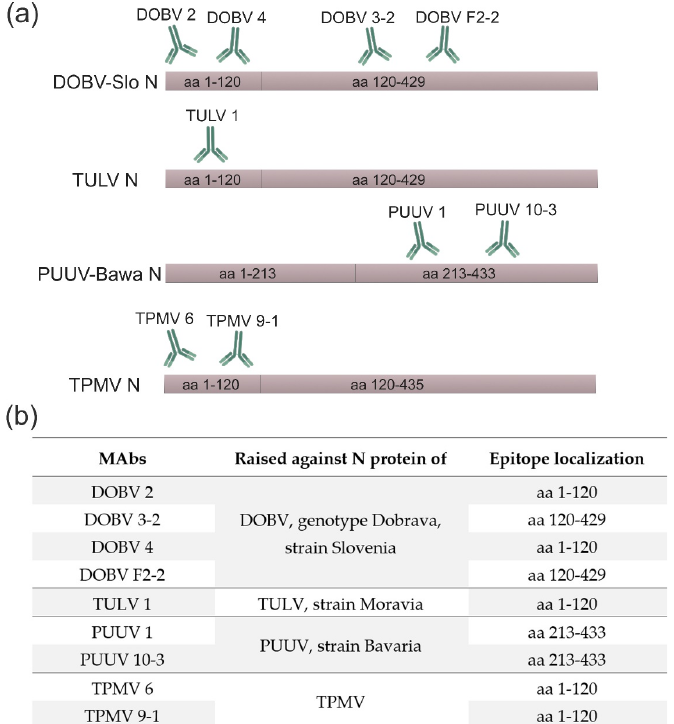
Figure 2. Epitope mapping of MAbs raised against N proteins of DOBV, TULV, PUUV and TPMV. ( a ) A schematic representation of binding regions of hantavirus-specific MAbs within corresponding hantavirus N proteins. ( b ) Epitope mapping data. DOBV-Slo— Dobrava-Belgrade orthohantavirus genotype Dobrava, strain Slovenia; TULV— Tula orthohantavirus; PUUV-Bawa— Puumala orthohantavirus strain Bavaria; TPMV— Thottapalayam thottimvirus .